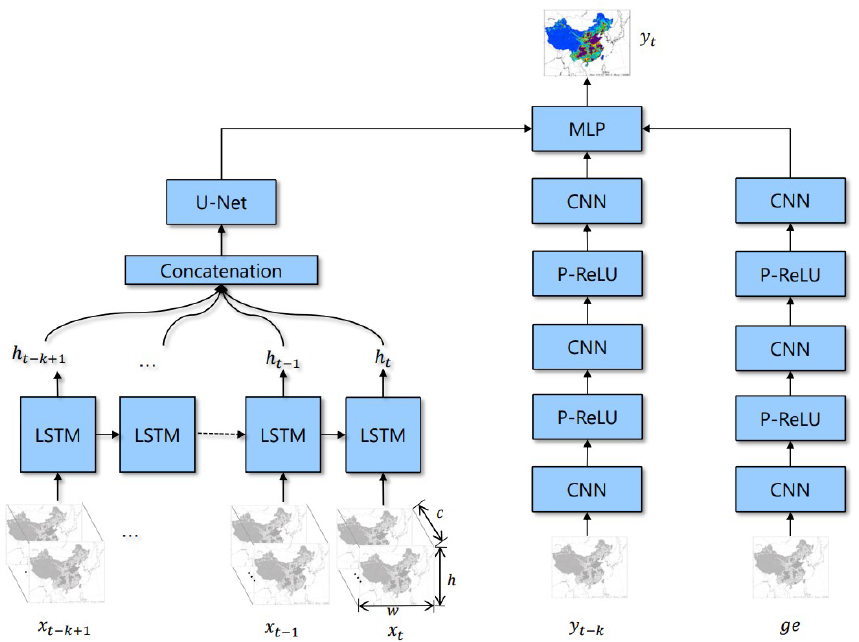
Figure 3. NN-CTM structure. c represents channel, which consists of the emission inventory and meteorological data. h and w represent the height and width of input, respectively. ge is geographic information. We employ long short-term memory (LSTM) to capture the temporal information and U-Net to capture the spatial information. CNN represents the convolution network. P-ReLU (He et al., 2015b) is a nonlinear activation function. MLP means multiple layers of perceptrons with threshold activation. The model structure is also named